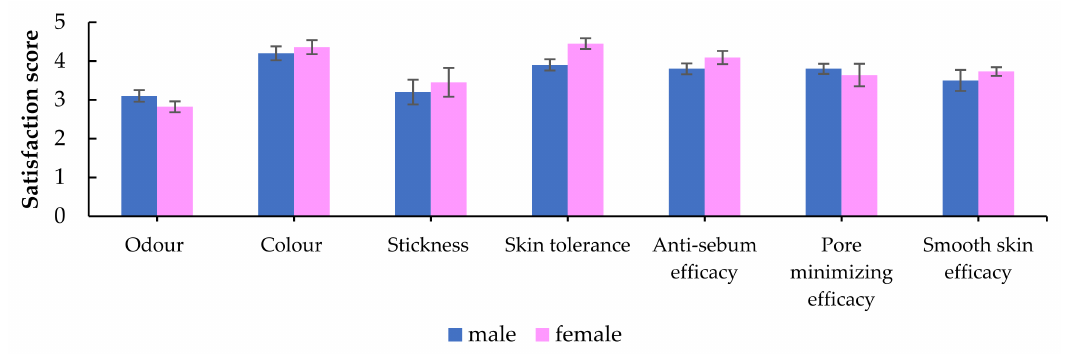
Figure 5. Volunteer satisfaction of the characteristics, tolerance, and efficacy of A. racemosus Willd. root extract solution (male n = 10, female n =